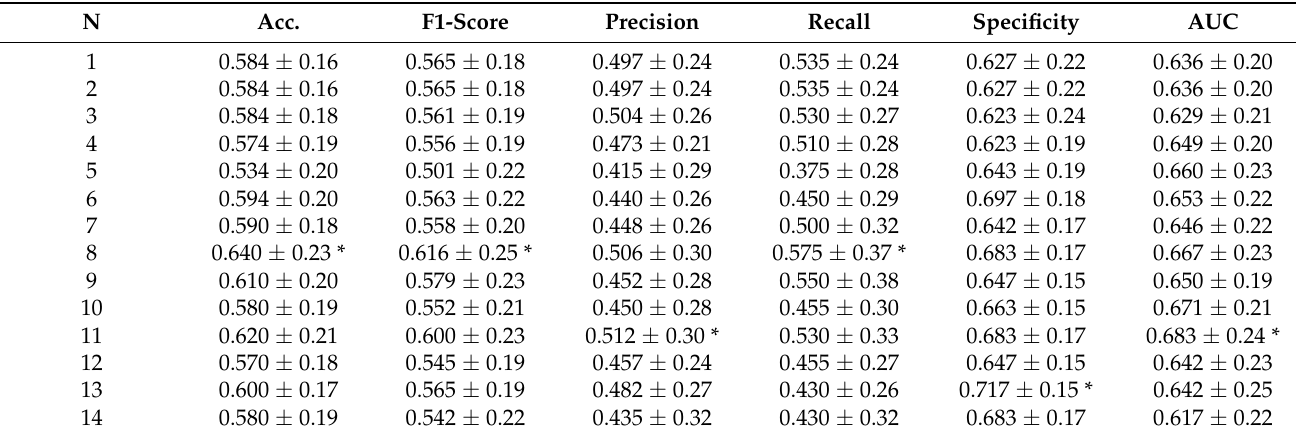
Table 4. Classification results for the random forest